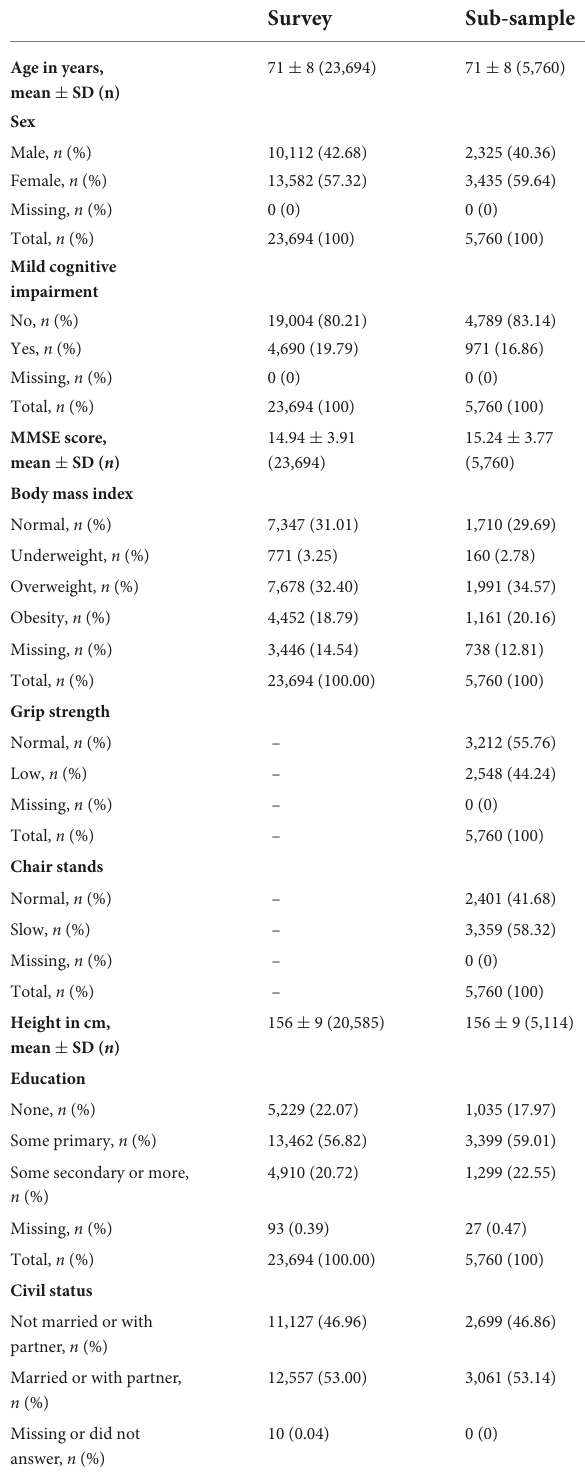
TABLE 1 Characteristics of participants in the National Survey of Health, Wellbeing and Aging in Colombia and the sub-sample in which sarcopenia was